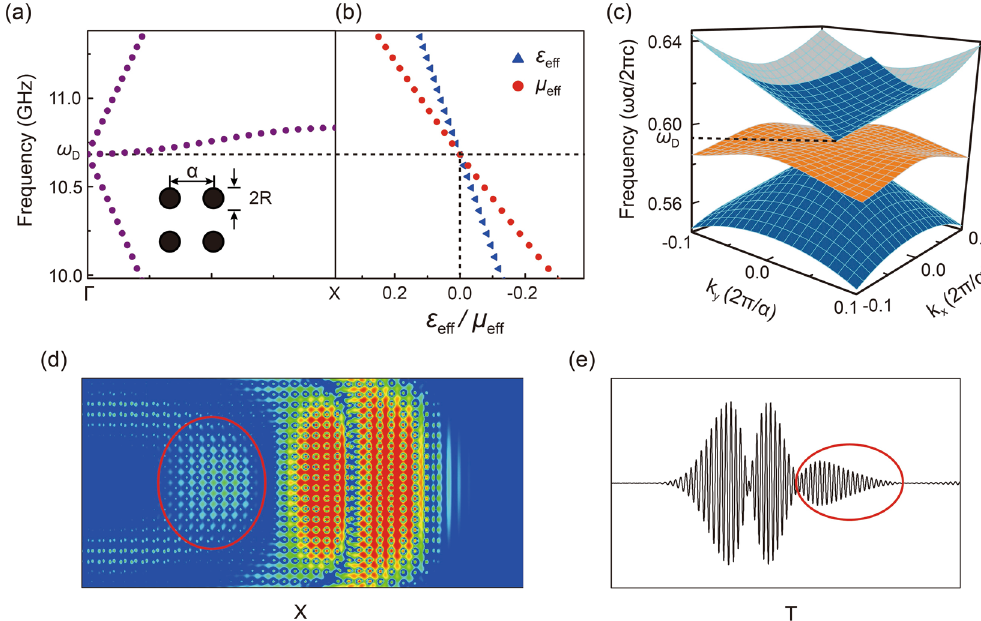
Figure 1. ( a,b ) TM photonic band diagram and effective permittivity/permeability shown in blue triangles/ red circles near the Dirac frequency ω D for a 2D square-latticed alumina cylinder array in air. ( c ) 3D TM band contour for the 2 nd , 3 rd and 4 th bands of such a PC. ( d ) Simulated electric field amplitude distribution of a Gaussian pulse incident from the left. ( e ) The received temporal evolution of the finite pulse at a probe point outside the